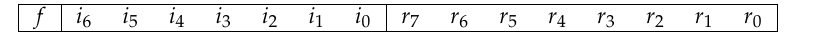
Figure 4. Definition of 16-bit data format for a reconstructable skeletal pixel (RSP)-pixel.